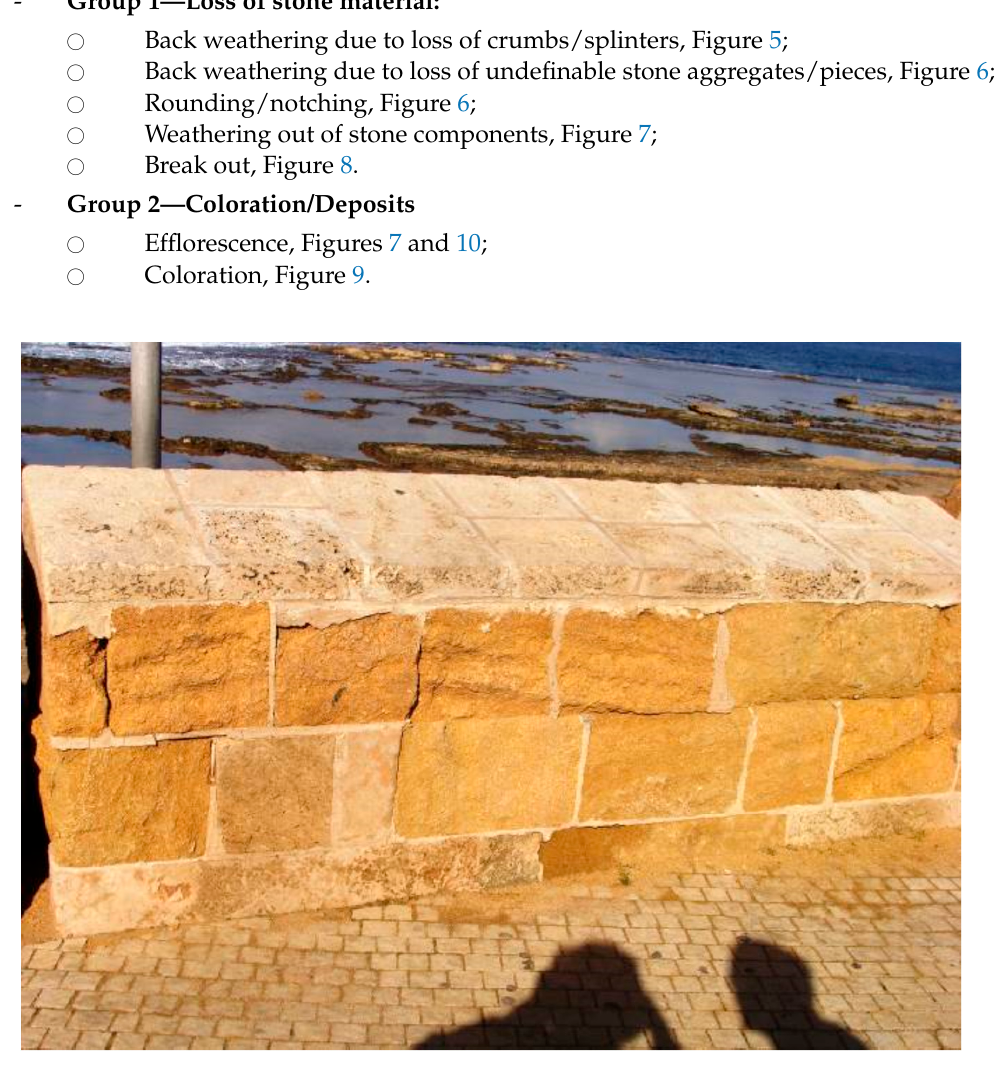
Figure 5. Back weathering of kurkar siding in the Panorama sea walls. Captured by the author on 22 July 2018.